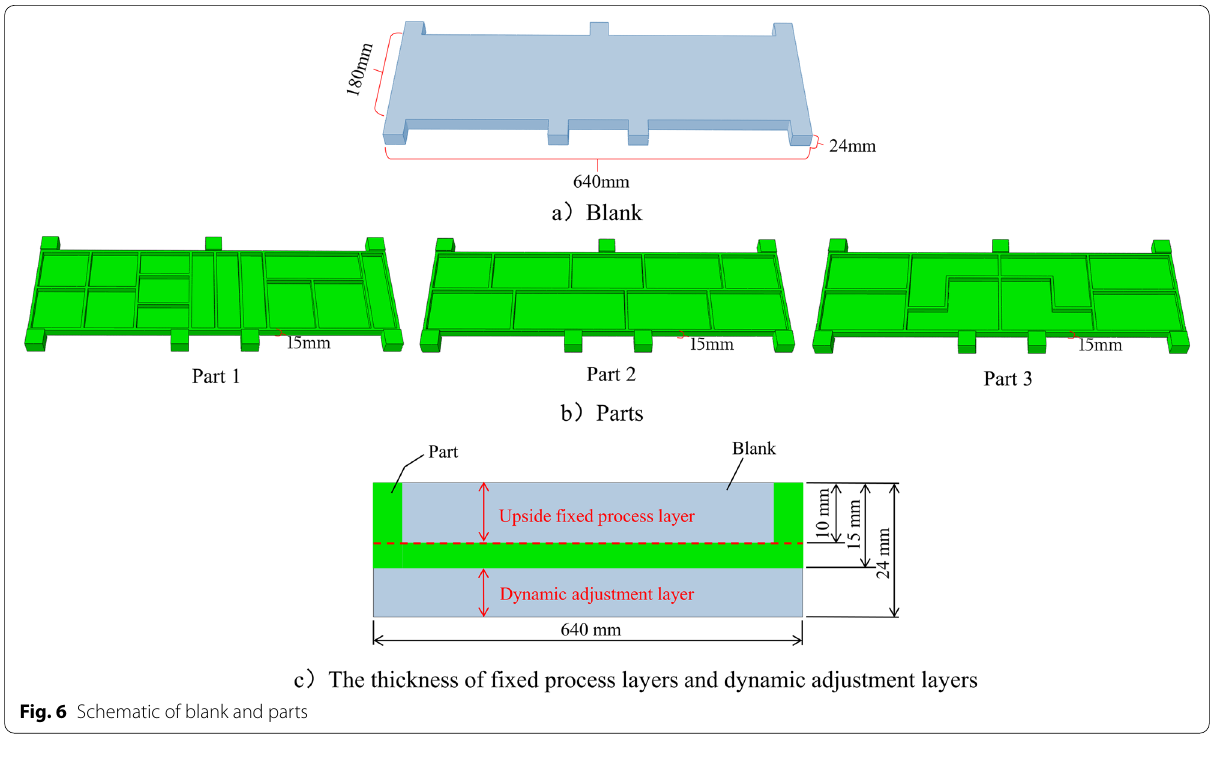
Fig. 6 Schematic of blank and parts